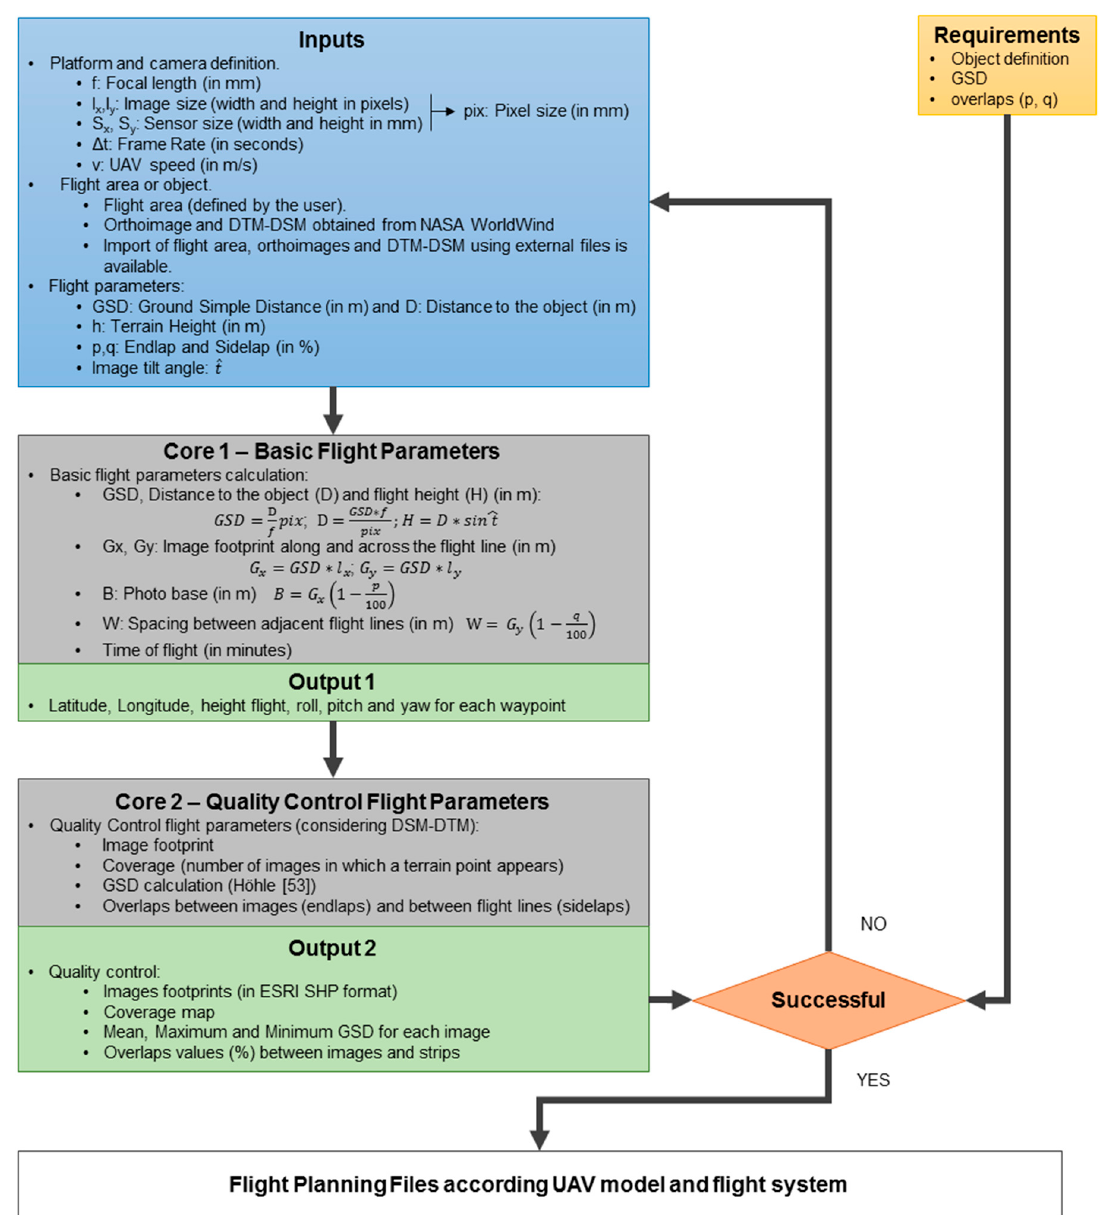
Figure 2. Schema of definition and application design.